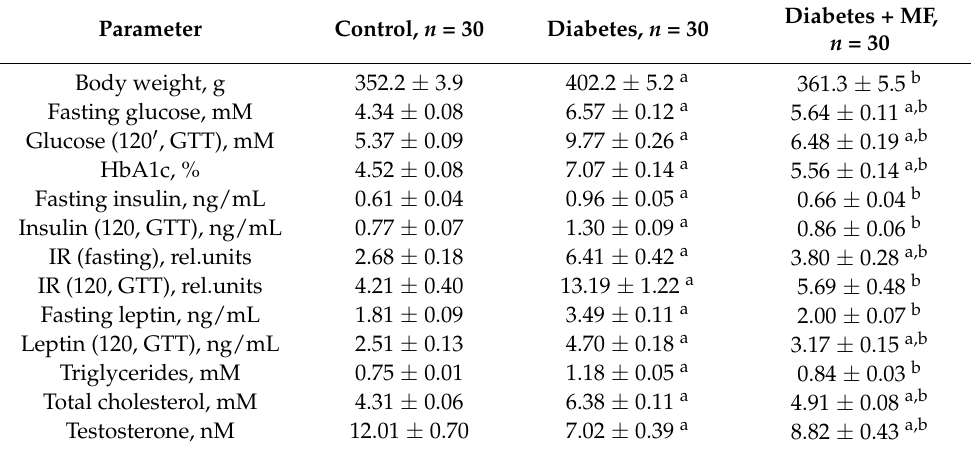
Diabetes + MF, n = 30